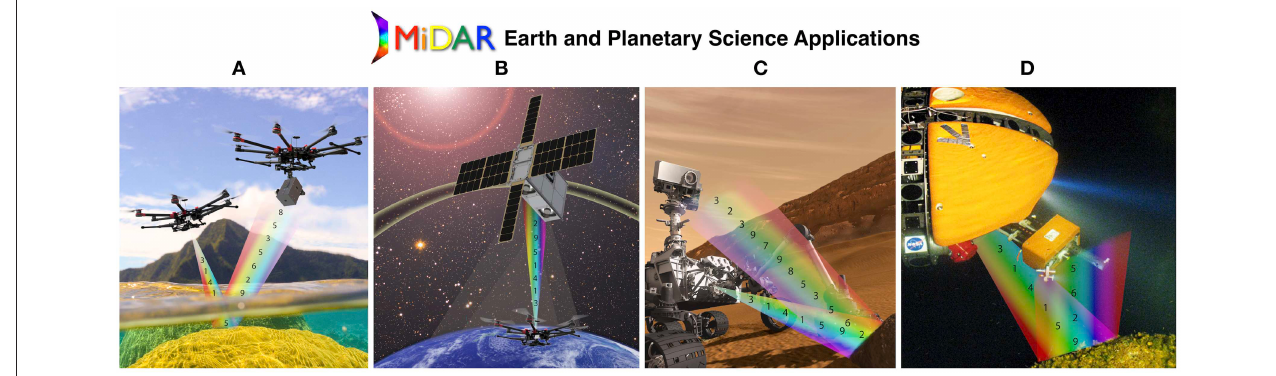
FIGURE 11 | MiDAR Earth & Planetary Science Applications. (A) Airborne MiDAR depicted operating over coral system with FluidCam in bistatic configuration. (B) MiDAR operating as high-bandwidth communications link to satellite system from same airborne transmitter. (C) MiDAR system integrated onto Mars rover for hyperspectral and UV sensing of facies. (D) MiDAR system integrated onto deep sea AUV for active multispectral benthic remote sensing in light-limited environment. Background image credit: NASA.